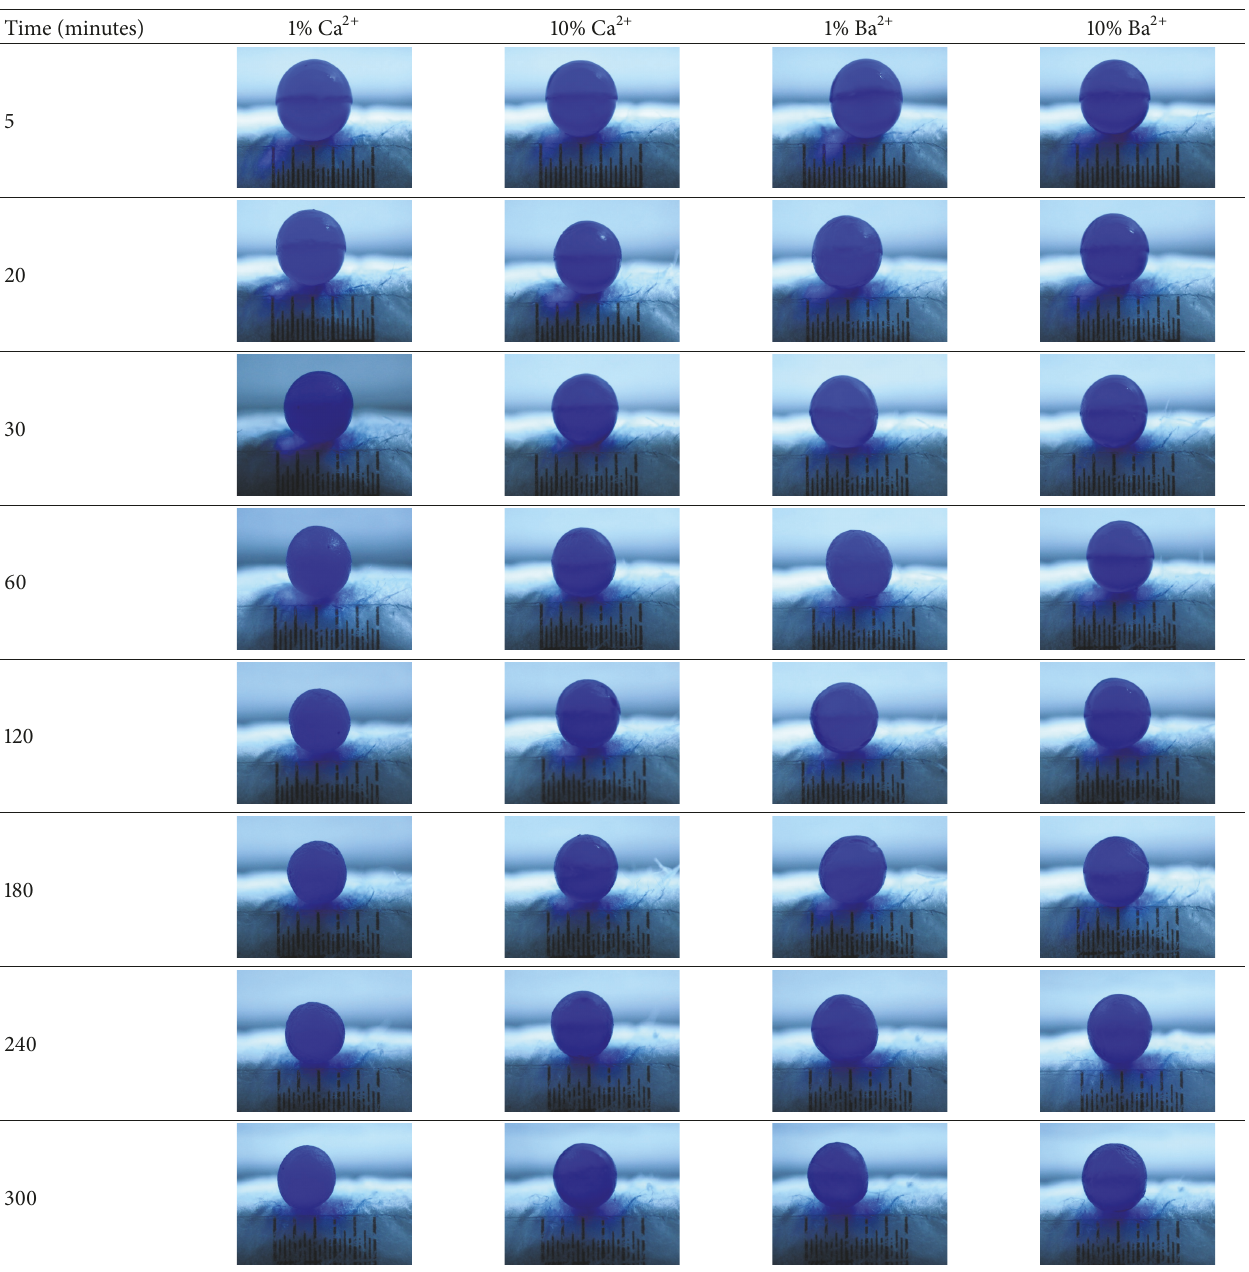
Table 1: Photographs of alginate beads incubated in different concentrations of Ca 2+ and Ba 2+ at room temperature (25 ∘ C) for various gelling